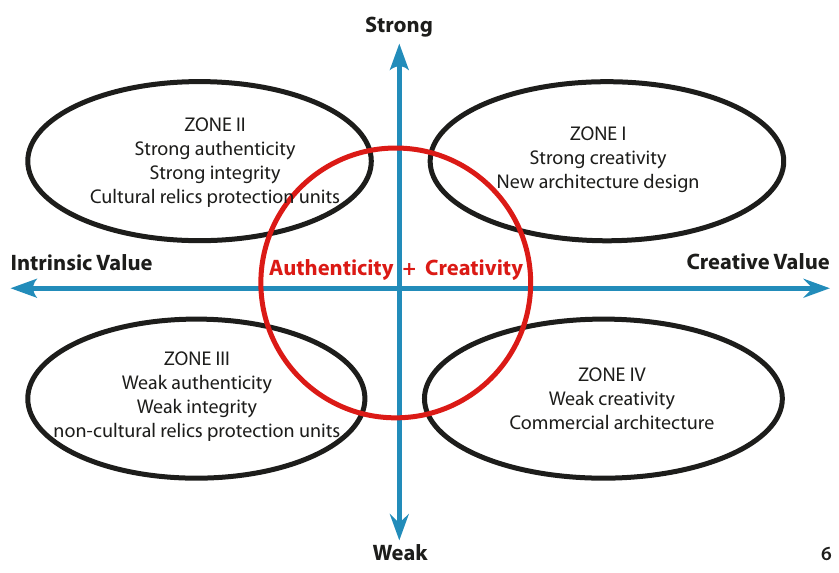
Figure 6 Schematic diagram of the ideal aims of heritage reconstruction and regeneration (Source: Subin